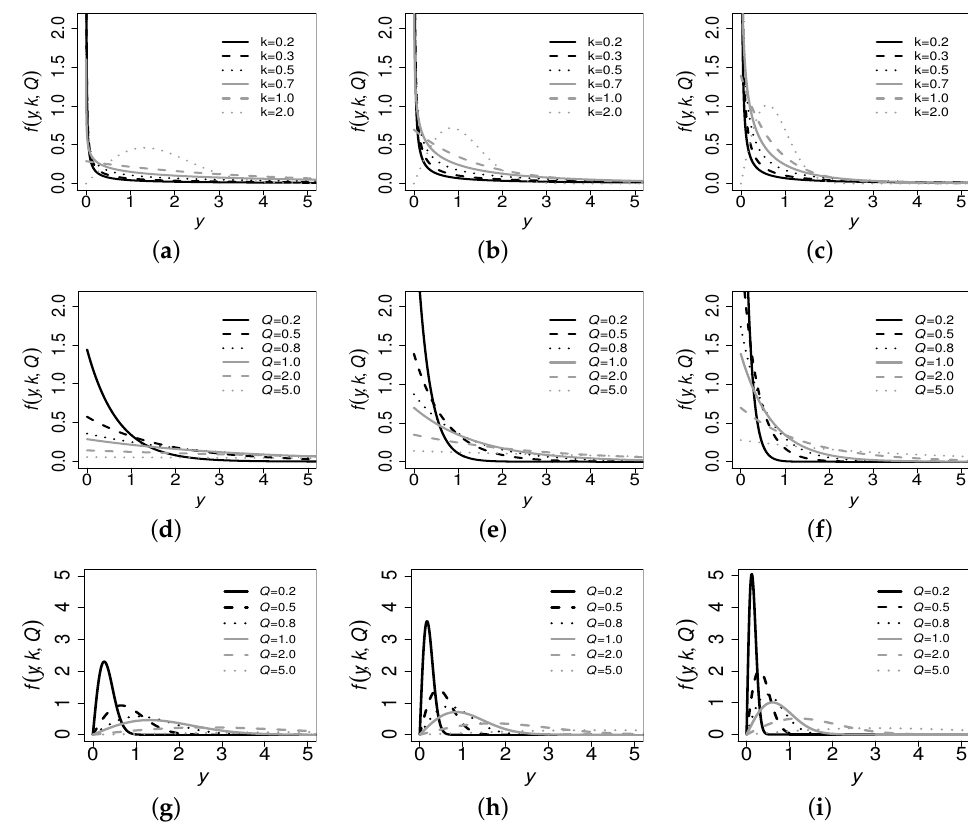
Figure 3. Plots of the Wei ( Q , k ) probability density function for q = 0.25 ( left ), q = 0.5 ( center ) and q = 0.75 ( right ), with Q = 1.0 ( a – c ), k = 1.0 ( d – f ) and k = 2.0 ( g – i